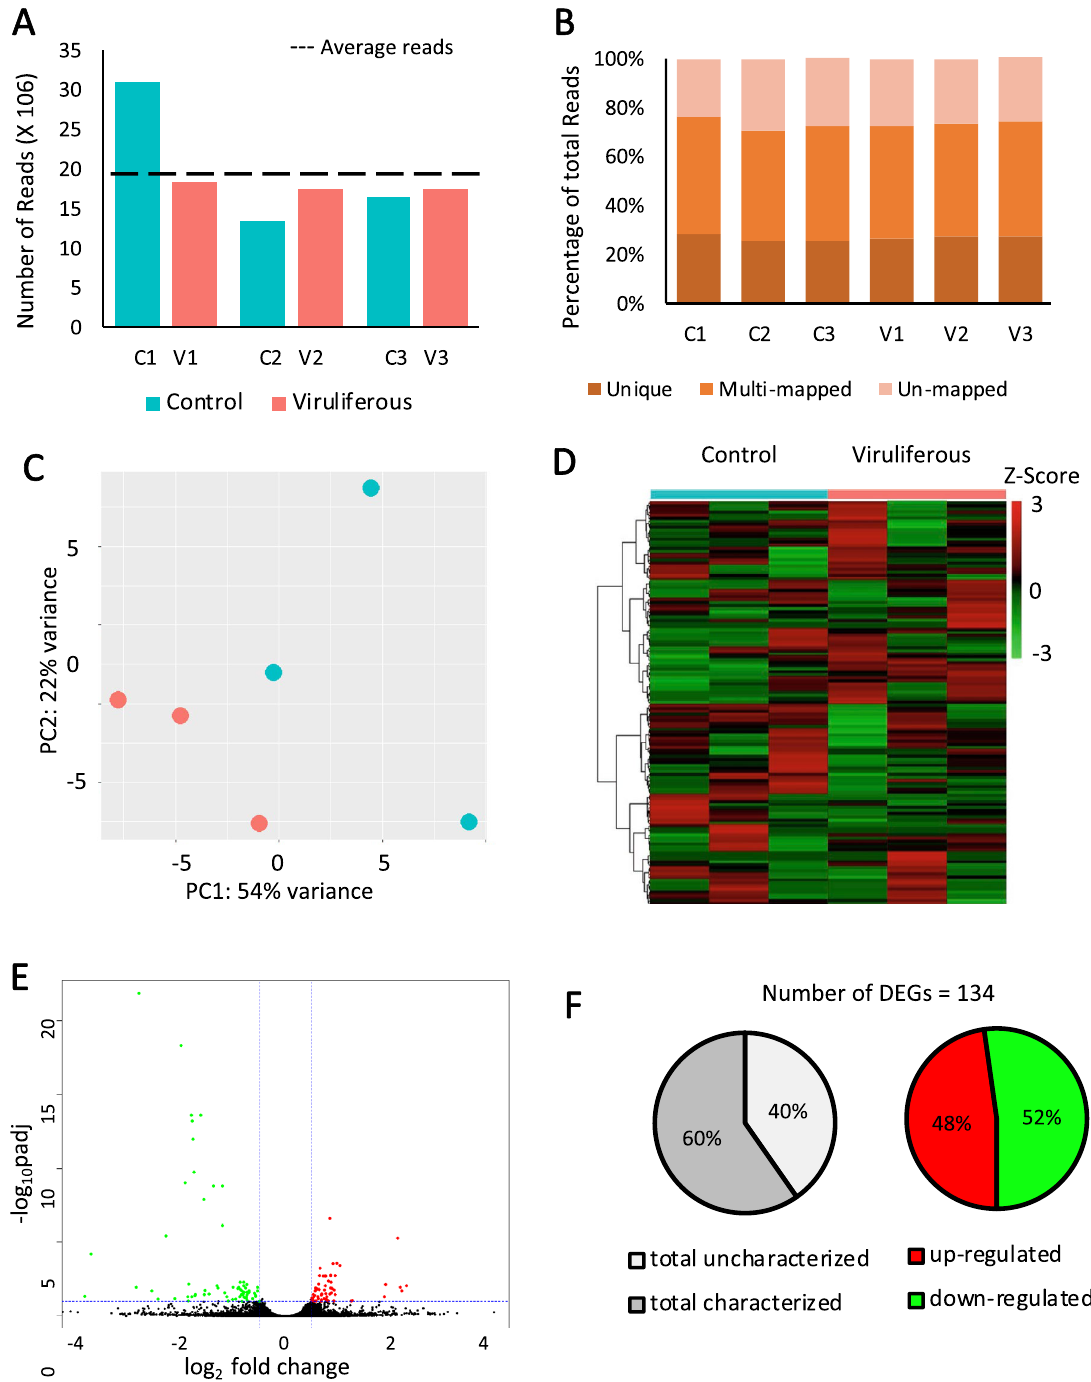
Figure 1. Overview of Myzus persicae transcriptome after Potato leafroll virus (PLRV) acquisition. (A) Number of paired-end reads generated for each library by Illumina HiSeq sequencing. The dashed line represents the average of paired-end reads from all 6 libraries. (B) Proportion of uniquely mapped, multimapped, and unmapped reads obtained for each library. Reads were mapped in the Myzus persicae clone G006 genome (AphidBase). (C) Principal component analysis of normalized count data from all samples. (D) Hierarchical clustering analysis of normalized count data z-scores exhibited by differentially expressed genes (DEGs) within each sample. (E) Volcano-plots of − log10p and log2FC exhibited by each gene in viruliferous aphids compared to controls. Up- and down-regulated genes are presented in red and green, respectively. (F) Numbers of up- and down-regulated DEGs in viruliferous aphids in comparison to control aphids. DEGs were identified using DESeq2 and defined by |log2FC|≥ 0.5 and false discovery rate (FDR)-corrected p-value ≤ 0.1. C = control aphids without virus; V = viruliferous aphids carrying PLRV, p = FDR-corrected